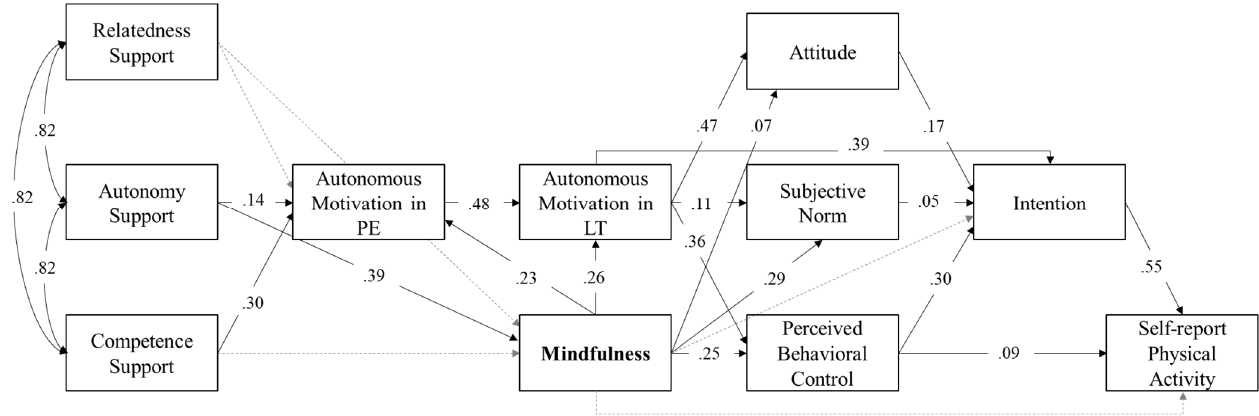
Figure 2. Path model (Model 1b) including mindfulness. Model comprised a sample size of N = 1877 students. All calculated and standardized estimation paths are presented. Significant paths are depicted by solid arrows ( p < .05), while non-significant paths are represented by dashed arrows ( p > .05). PE = Physical education context; LT = Leisure time context.